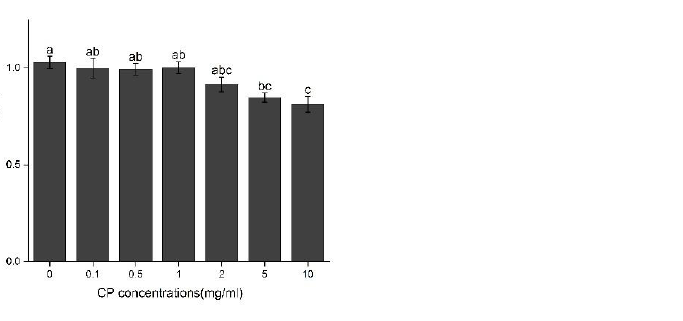
Figure 6. Effect of CPs concentration on cell viability in Kupffer cells after 12 h treatment. Different letters represented the significant difference at p < 0.05.